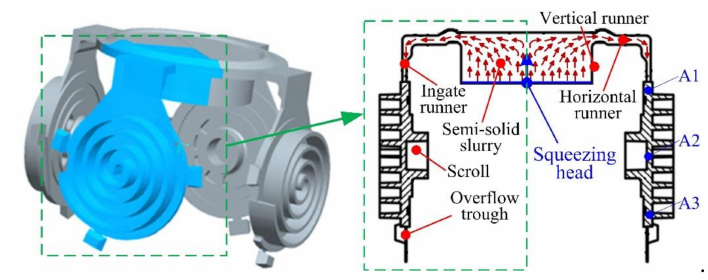
Figure 4. Schematic diagram of the whole SMSC process for fabricating four scrolls with one